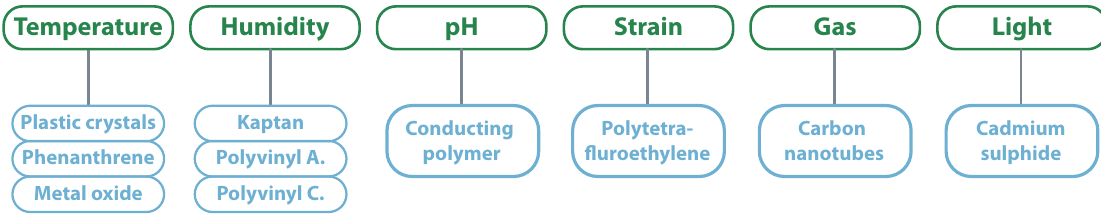
Figure 11. Classification of smart materials.